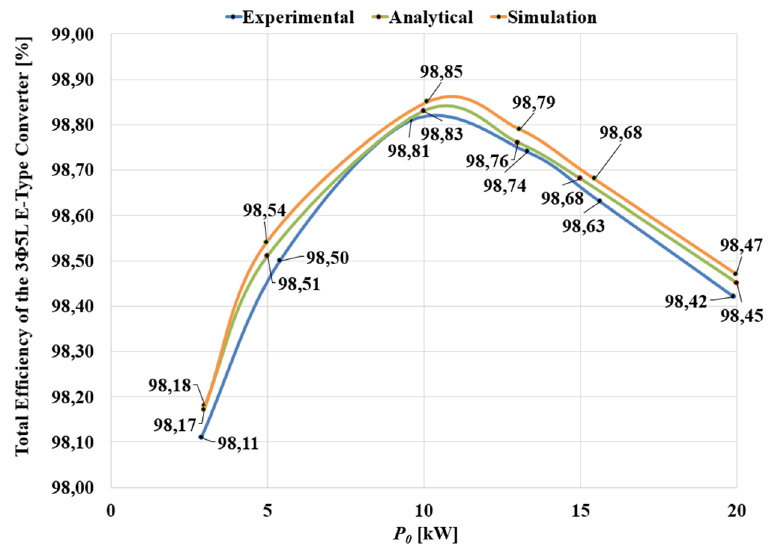
Figure 24. Total efficiency of the 3 Φ 5L E-Type MMC as a function of the power P 0 : analytical result (green line), simulation result (orange line) and experimental result (blue line).